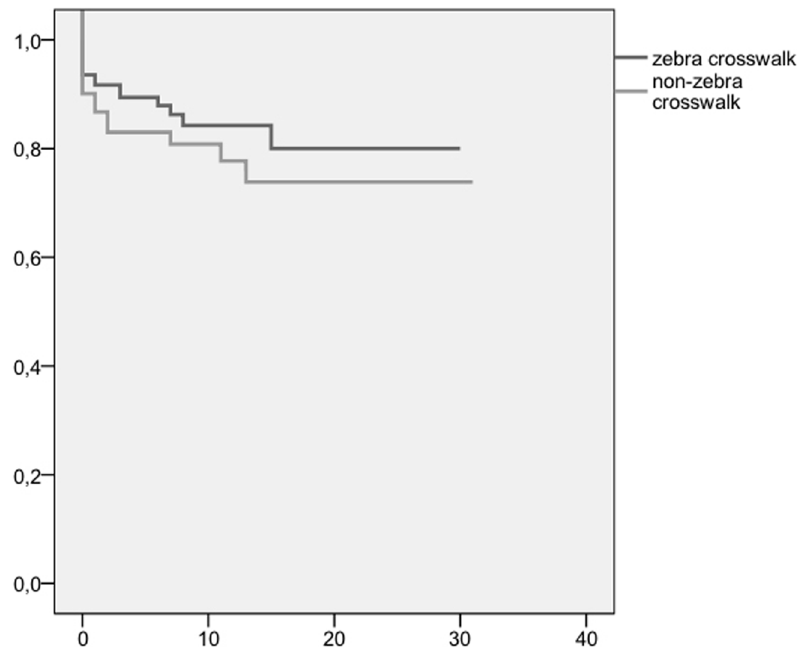
Figure 2. Kaplan Meier Curve for in hospital mortality (p , 0.57).